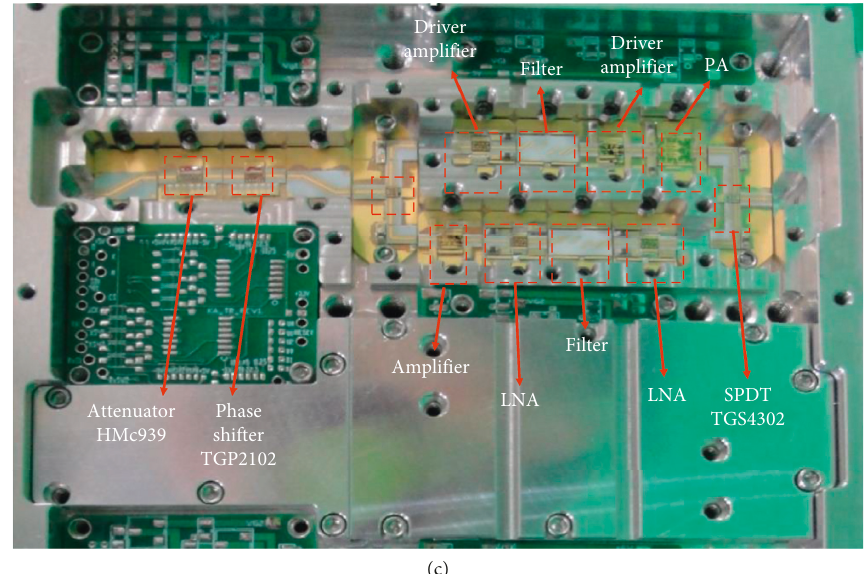
Figure 6: Photographs of feeding networks and the fabricated array: (a) side view, (b) three subarrays, and (c) Ka-band TRM.